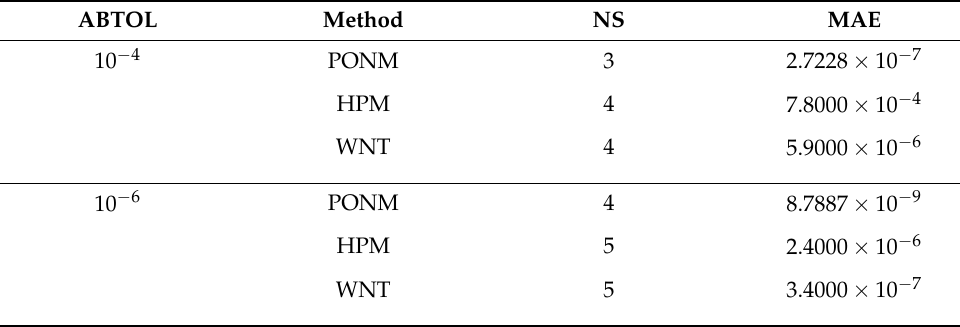
Table 1. Comparison of the numerical results on Problem 6 with x ∈ [ 0,1 ]